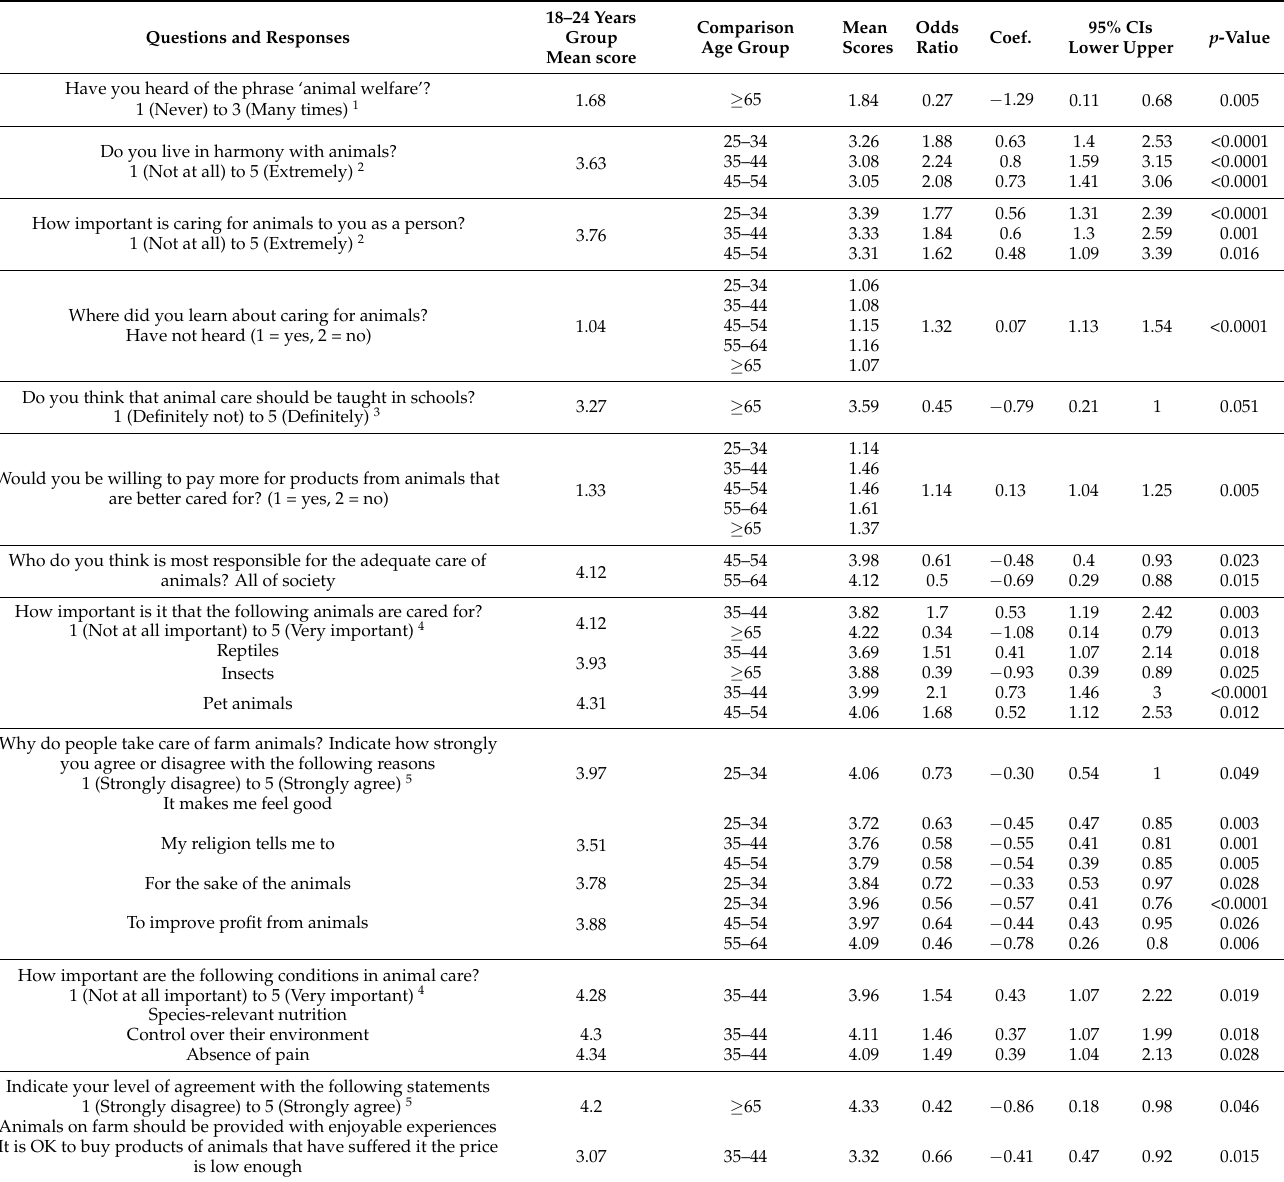
Table 3. Age effects on respondents’ perception of attitudes towards animal welfare in China. Mean responses on the binary, 3-point or 5-point ordinal scales are provided. Differences are presented between the reference age group 18–24 years, n = 430, compared with other groups, age 25–34